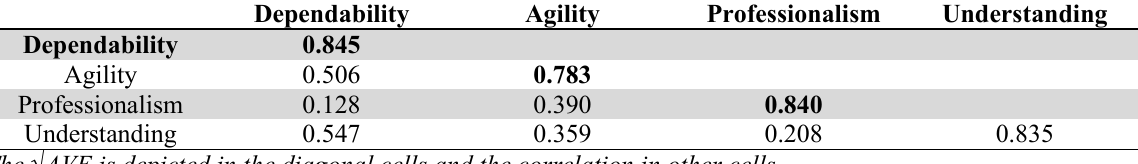
Results of Discriminant Validity for the scale for measuring Employee Service Quality Dependability